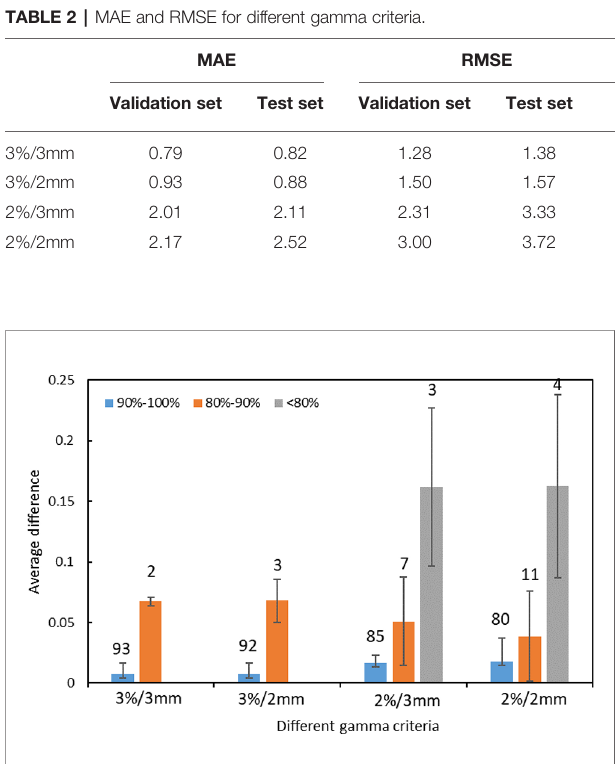
FIGURE 3 | The distribution of prediction errors in test set among different groups under different gamma criteria. (Error bar: Mean ± standard deviation. The number on the vertical axis represents the number of fi elds for different